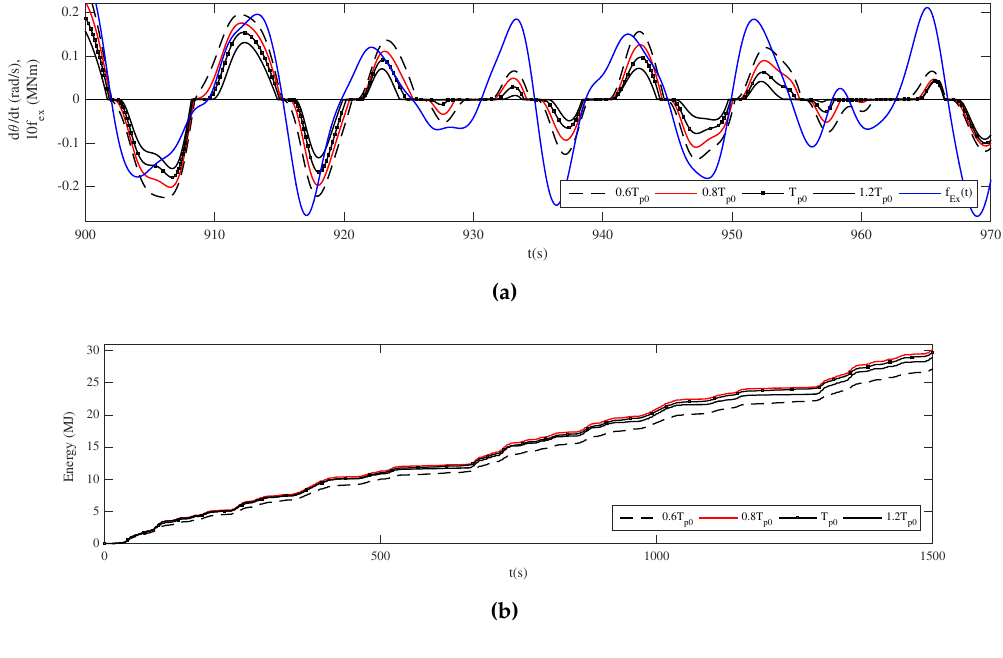
Figure 16. ( a ) Variation of angular velocity of the flap and wave excitation moment for different loading conditions; ( b ) Cumulative energy capture with